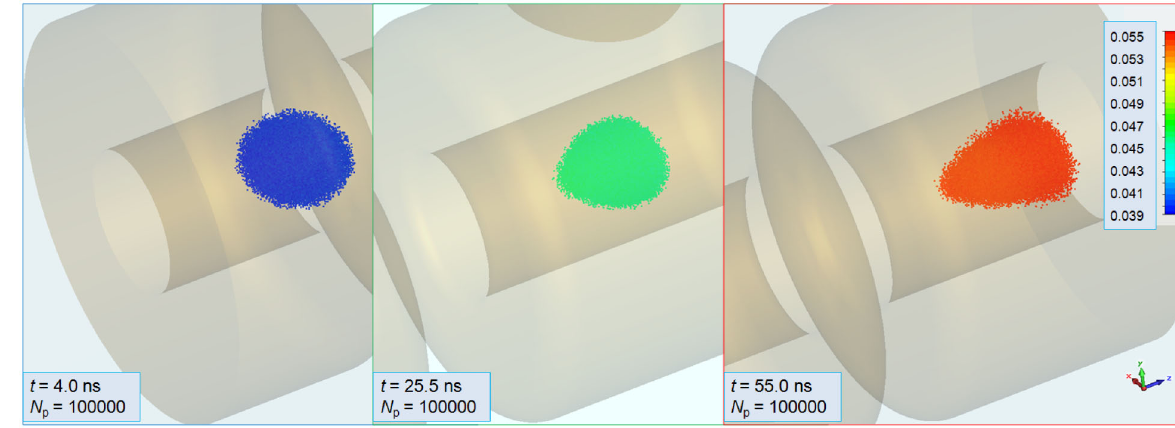
FIG. 20. Evolution of a Gaussian bunch with 100 K particles in the IH-PMQ tank computed by the CST PARTICLE STUDIO : near the entrance, in the middle, and near the exit. Color changes indicate the particle-energy increase ( (cid:1) scale